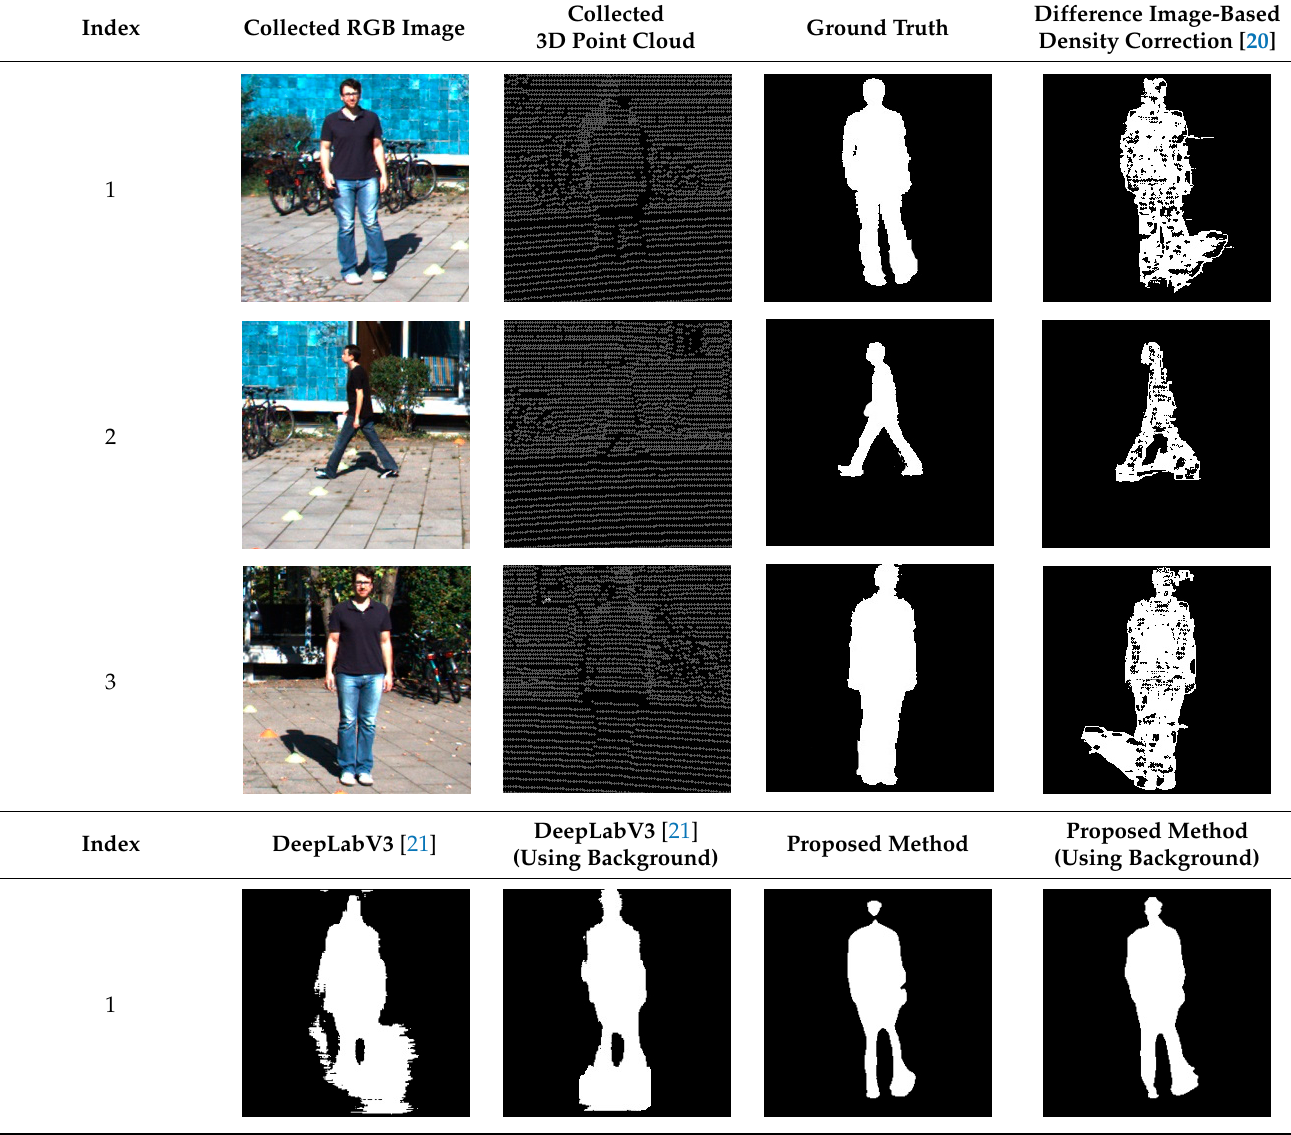
Table A1. Dense segmentation image result of each method.